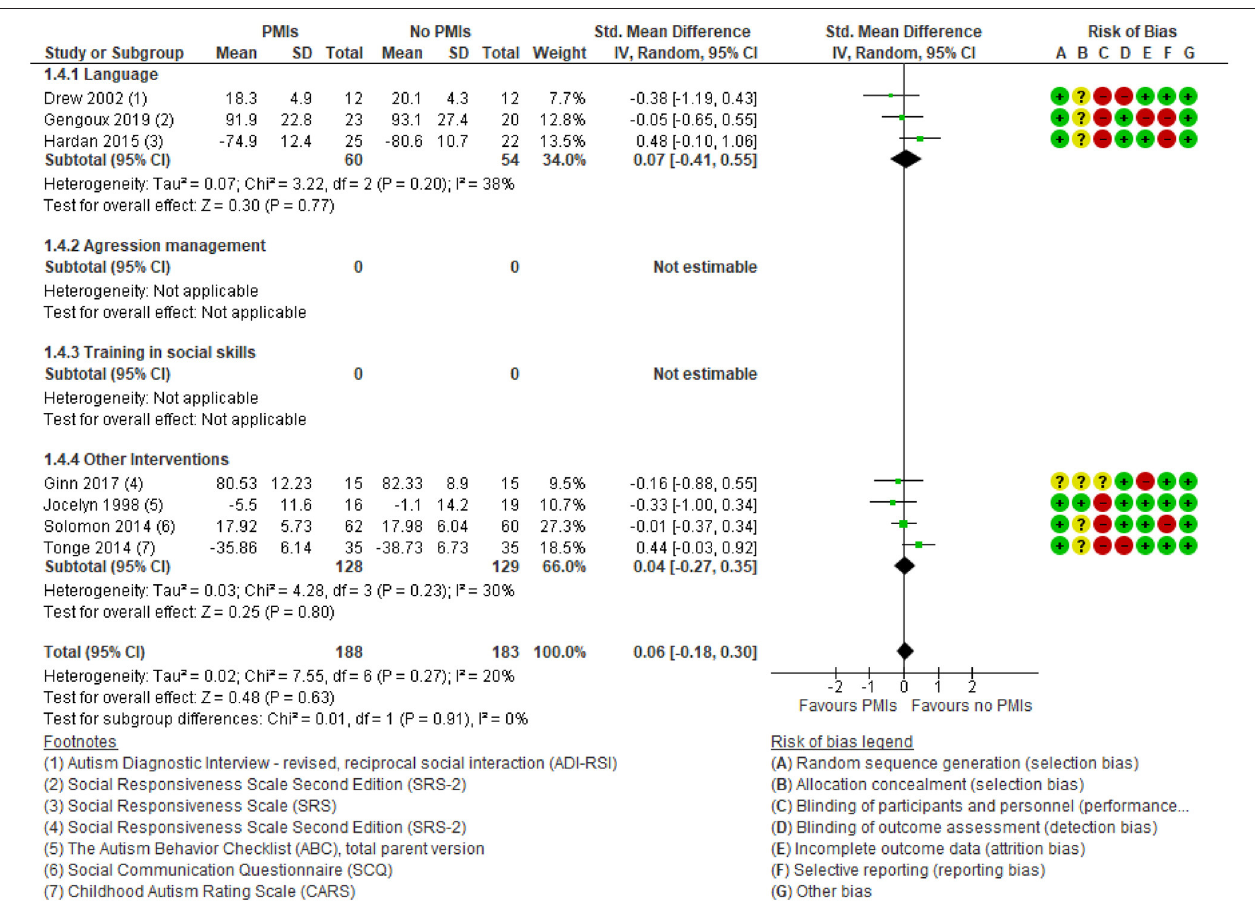
FIGURE 7 | Forest plot of comparison: PMI vs. no PMI, outcome: autism core symptoms, parent-rated.